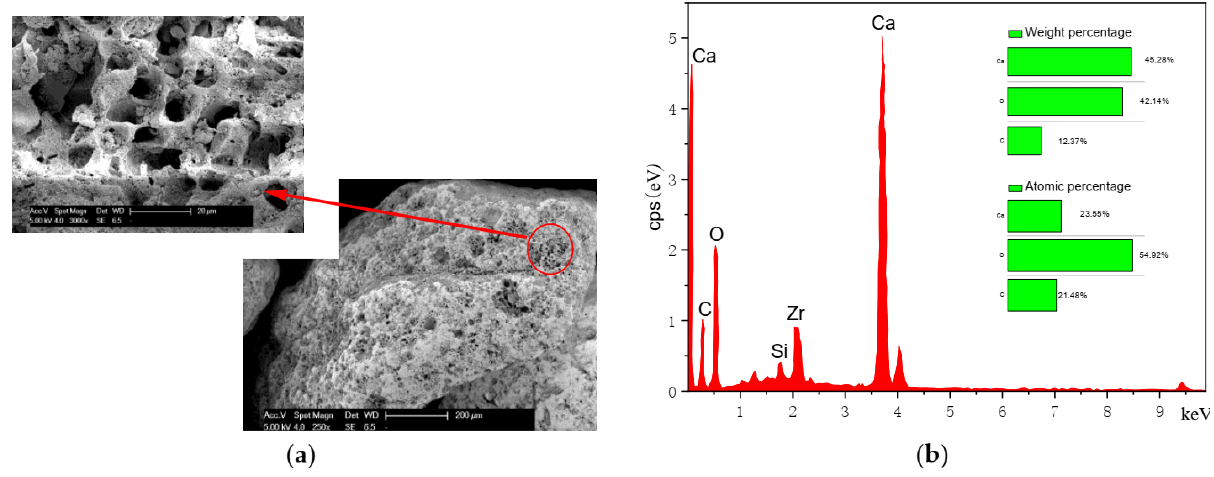
Figure 1. ( a ) Representative scanning electron microscope images of carbonate sand; ( b ) EDS results.